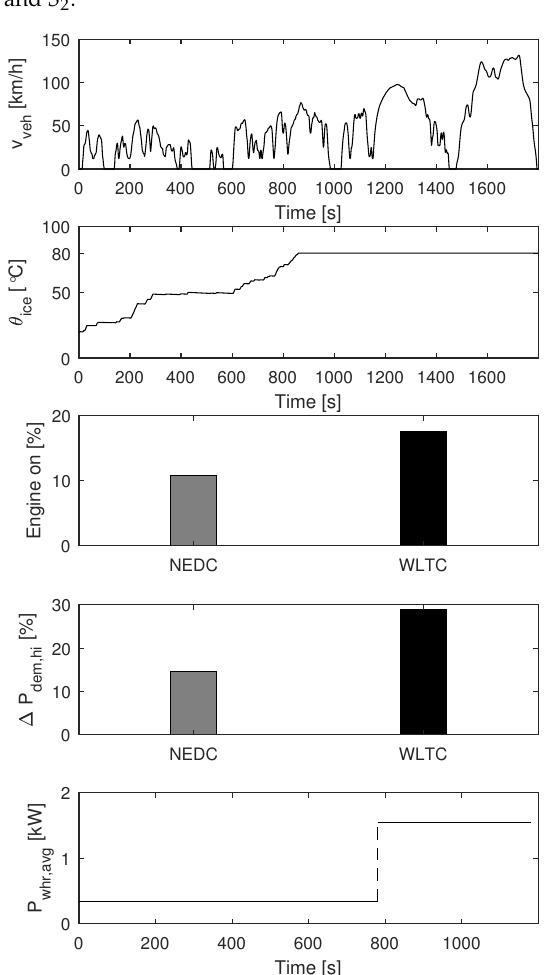
Figure 4. Influence of driving conditions on the fuel-saving potential and the waste heat recovery. ( Top to bottom ) Vehicle velocity of the Worldwide Harmonized Light Vehicles Test Cycles (WLTC) ( v veh ), engine temperature on the WLTC ( θ ice ), comparison of the engine-on time between the New European Driving Cycle (NEDC) and the WLTC for the first 780 s (Engine on), comparison of the high driving power demand between the NEDC and the WLTC for the first 780 s ( ∆ P dem , hi ) and the average recovered power during the urban and highway parts on the NEDC ( P whr , avg